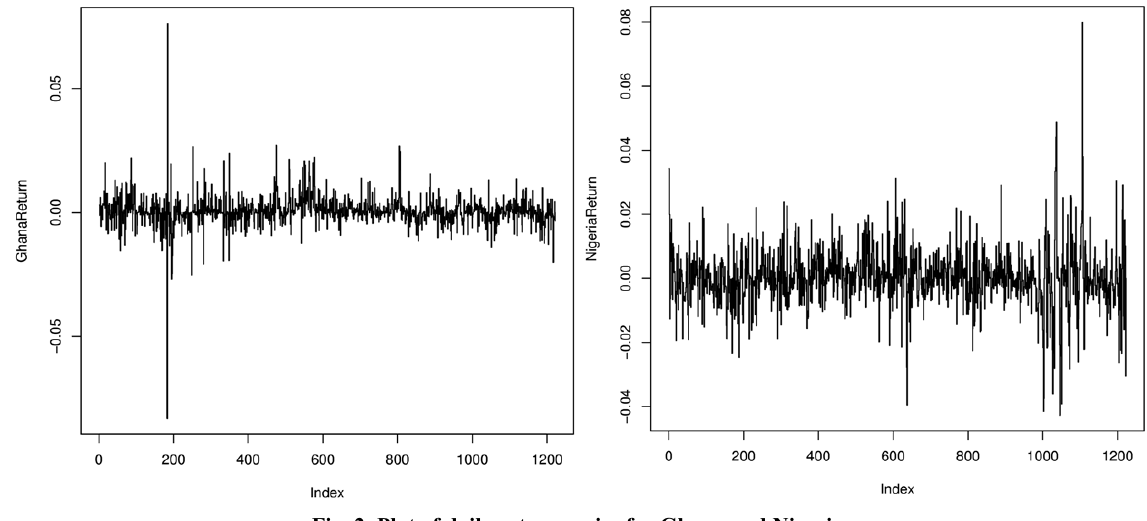
Fig. 2. Plot of daily return series for Ghana and Nigeria